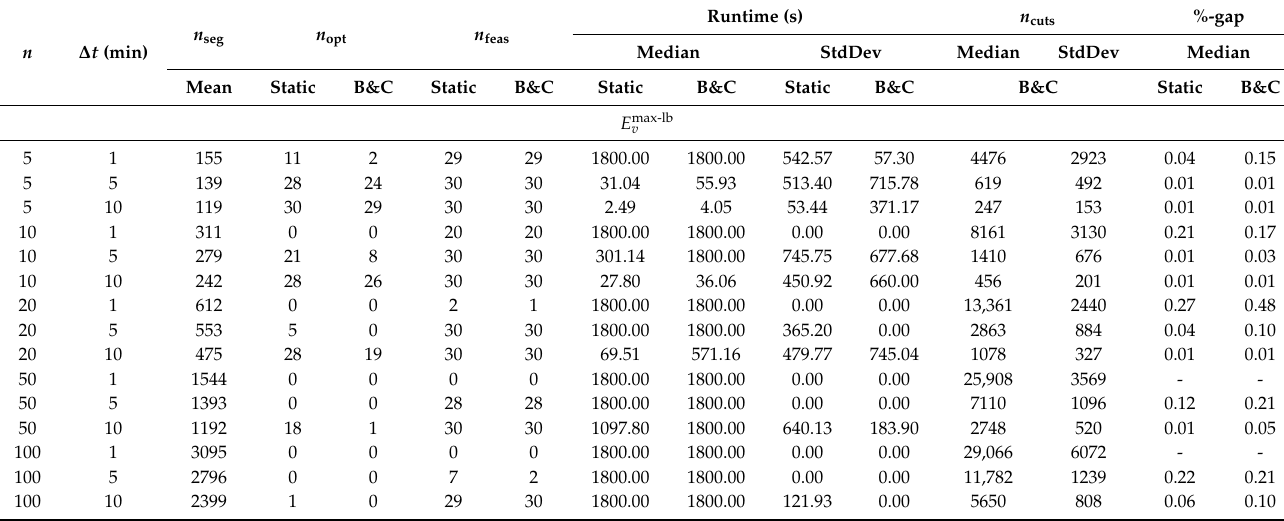
Table A3. EVS-SOC-GLIN results for solving the static model versus B&C with E max-lb v and E max-ex v based on the original P max v functions and P gridmax = 40 n